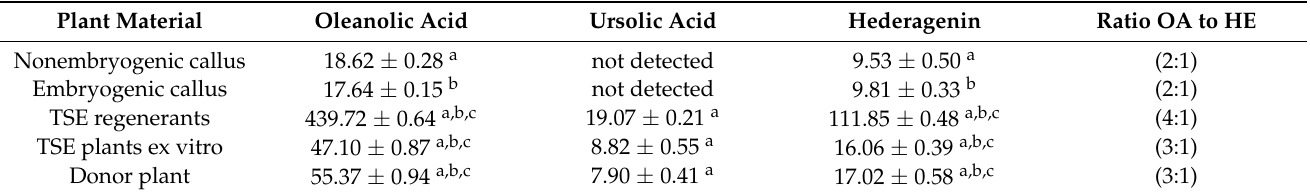
Table 5. The effect of solvent type and method of extraction on the yield of triterpene aglycones [ µ g/g DW] in Polyscias filicifolia TSE regenerants cultured in vitro.